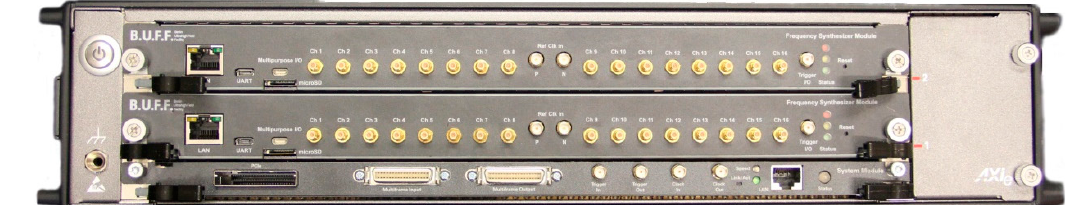
Figure 1. Sixteen-channel frequency synthesizer module (top): The black module is a system-on-module unit AES-ZU3EG-1-SOM-I-G (Avnet, Phoenix, AZ, USA); the red module is an open source intelligent platform management controller card. Electromagnetic interference shielding covering the 16 RF channels was not installed for acquisition of the photo. The top cover of this module was also removed for better presentation. Two 16-channel frequency synthesizer modules installed in the AXIe chassis are shown at the bottom.